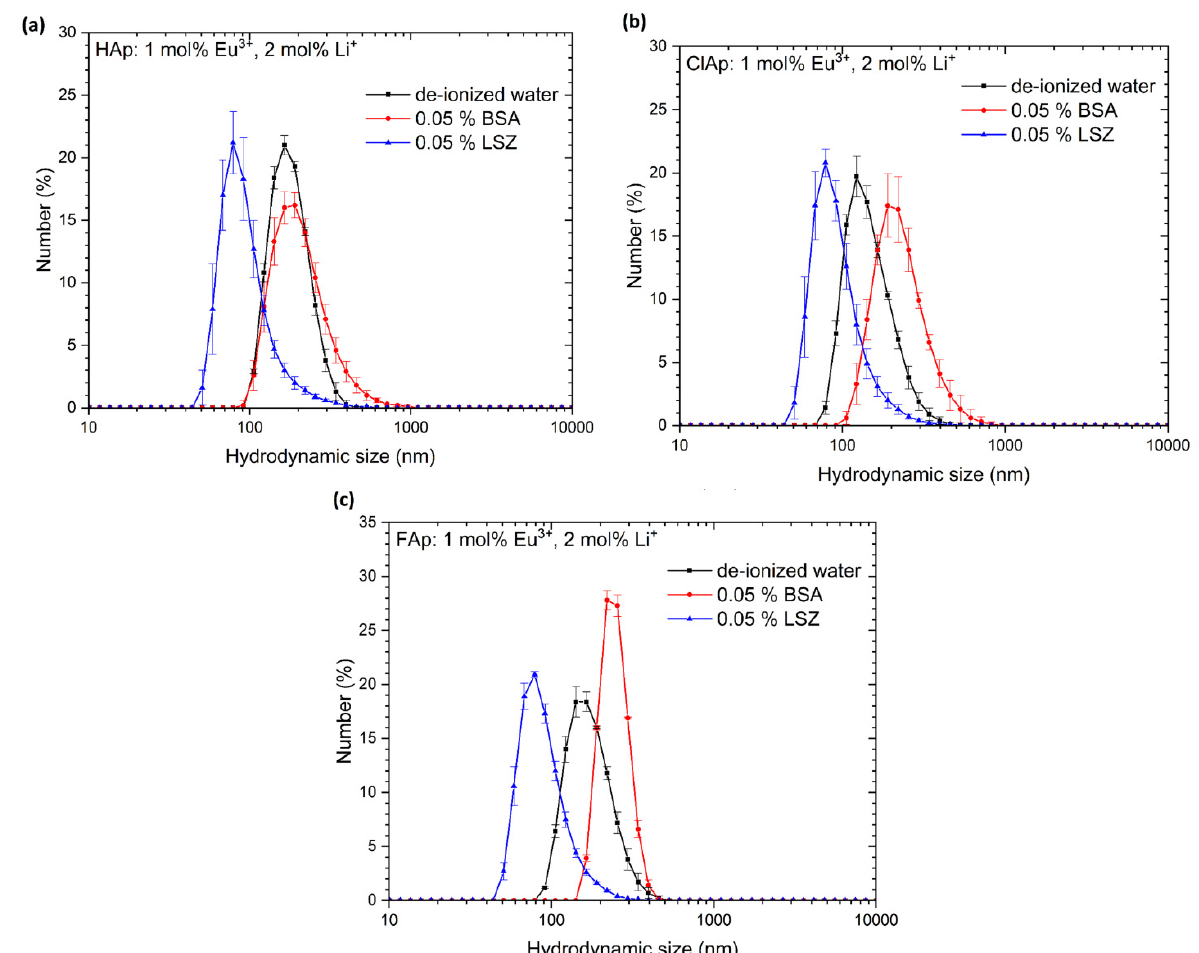
Figure 5. Hydrodynamic size distribution of the nanoapatites water colloidal suspensions: Ca 10 (PO 4 ) 6 (OH) 2 ( a ), Ca 10 (PO 4 ) 6 Cl 2 ( b ) and Ca 10 (PO 4 ) 6 F 2 ( c ) co-doped with 1 mol% Eu 3+ and 2 mol% Li + ions. Presented values are the mean ± SD of three independent experiments.